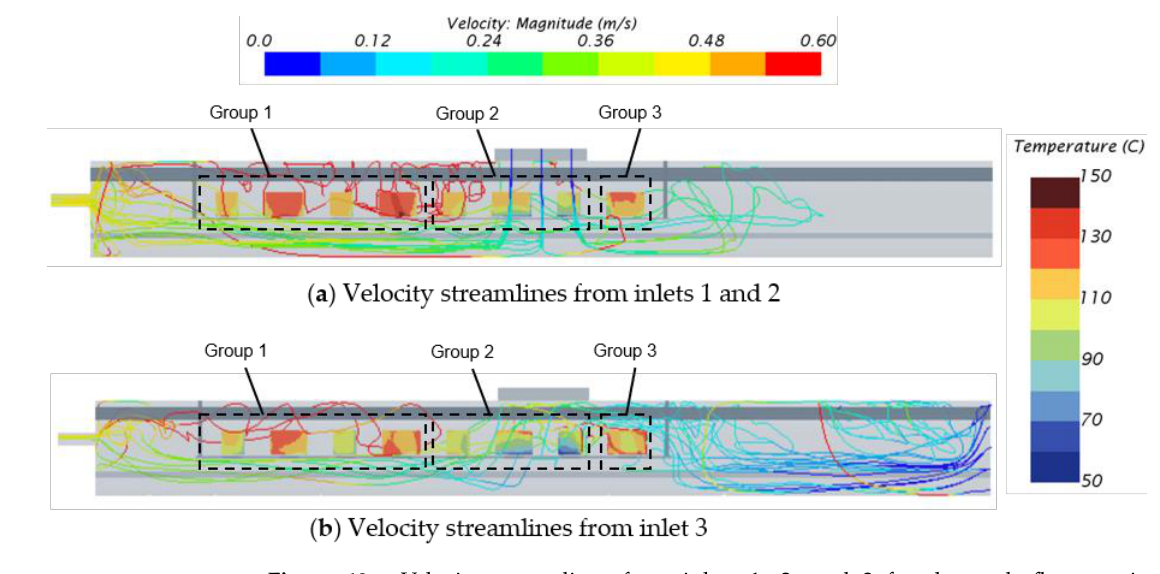
Figure 11. Side view of the underfloor equipment bay (Configuration 2).